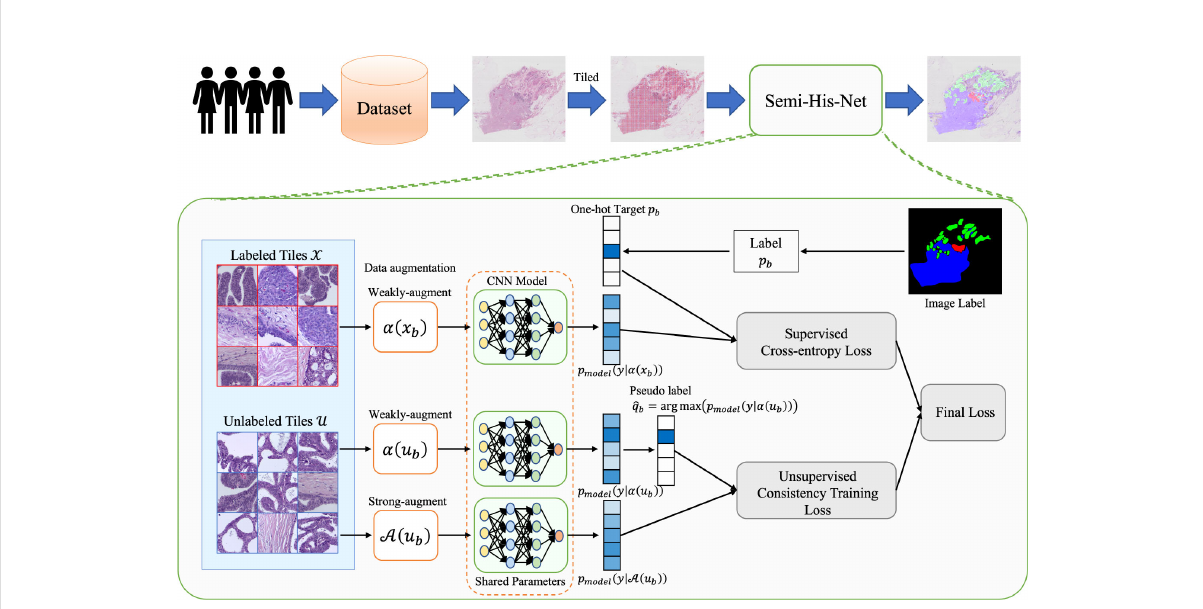
FIGURE 2 Method overview: the proposed semi-supervised histopathology image analysis method for WSIs. We learn the parameters for a CNN classi fi cation model that maps the tiled histopathology images to the tumor subtype. To make unlabeled images participate in model training, the pseudo-labels are estimated from the predicted category probability distribution of the classi fi